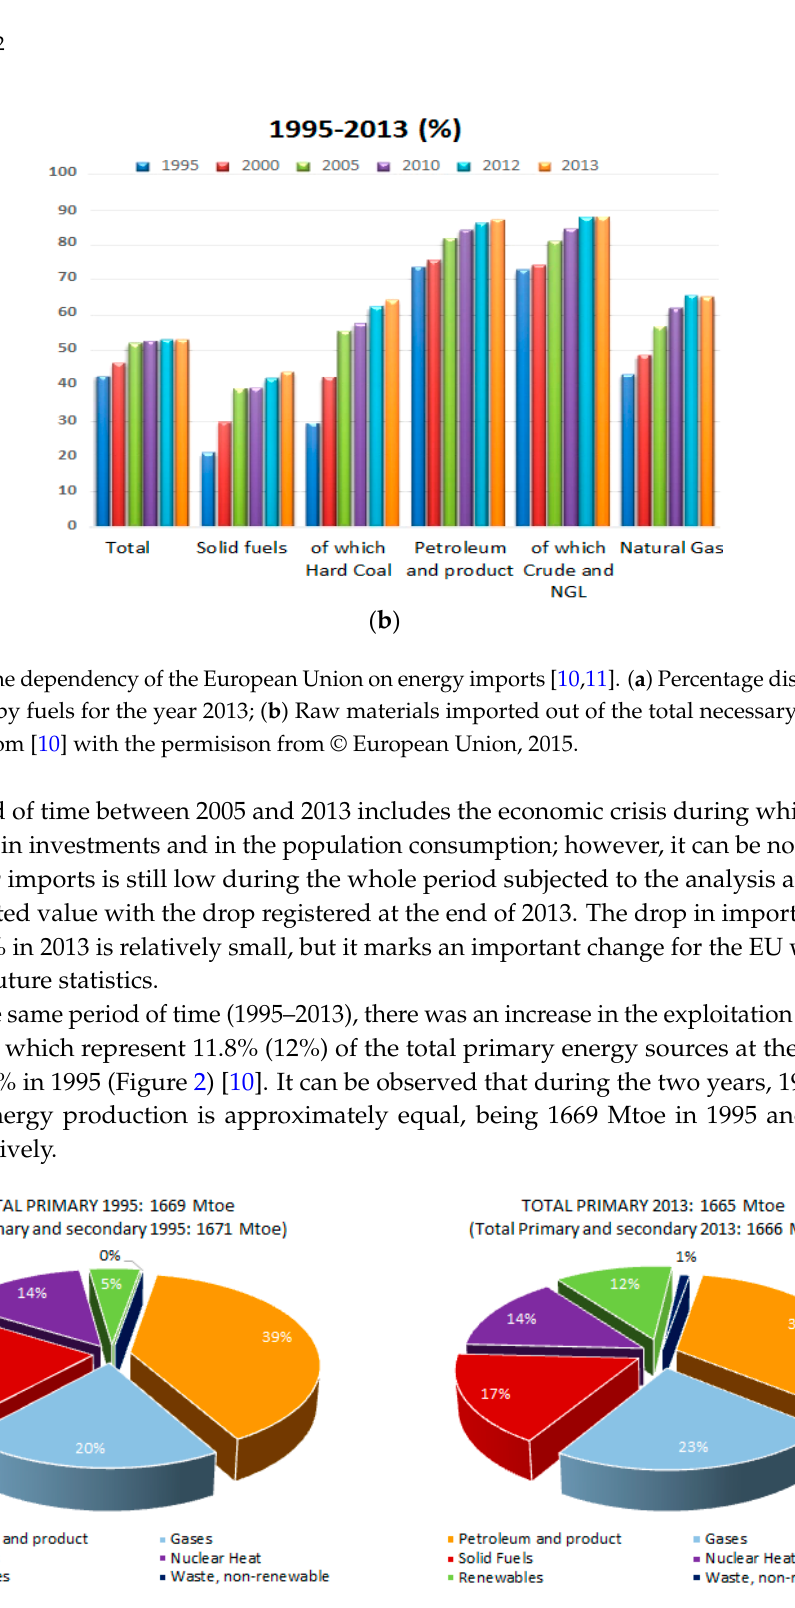
Figure 2. Energy Mix 1995 and 2013 (%)—Primary Products Only [10,11]. Adapted from [10] with the permisison from © European Union, 2015.